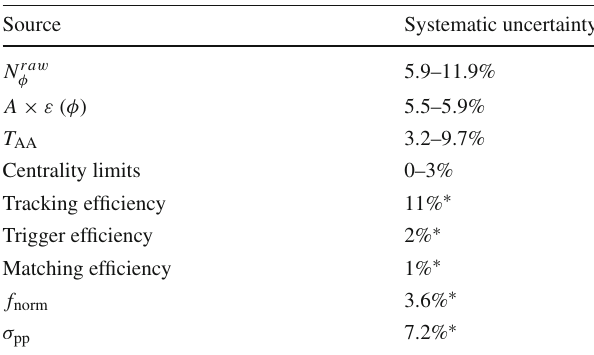
Table 5 Systematic uncertainties for R AA as a function of 2 < p T < 5 GeV/c; the correlated uncertainties are marked with an